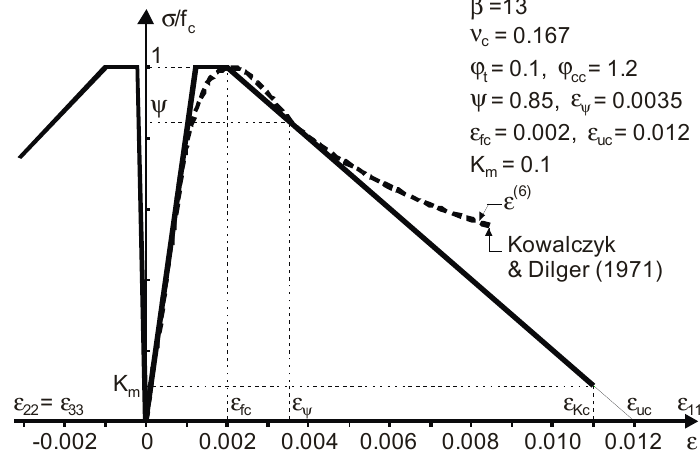
Figure 14. Comparison of the proposed model with the average dynamic curve according to Kowalczyk and Dilger [18].